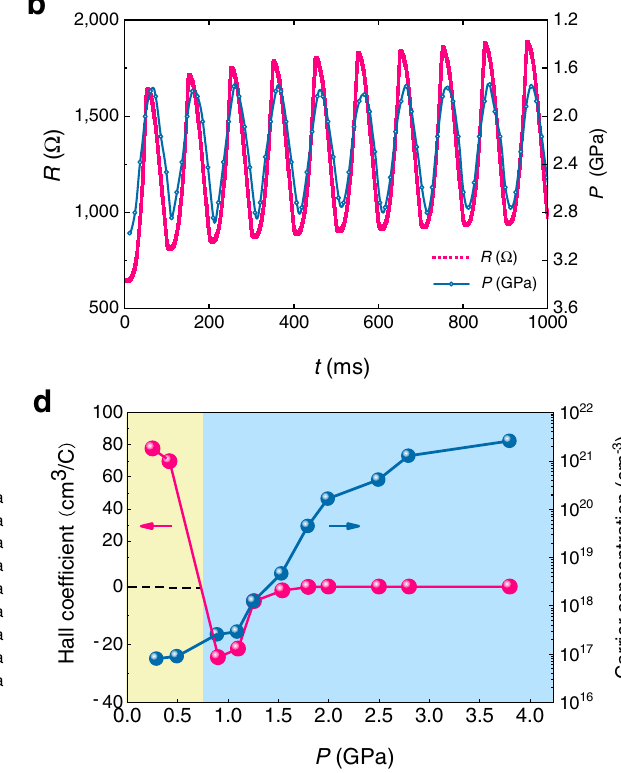
Fig.1|Pressure-inducedresistancedropandHallcoef fi cientmeasurementof β ′ -In 2 Se 3 . a Pressure-dependent resistivity at room temperature. The piezoresistive gauge π p is estimated from the exponential fi t to the data (dashed line) which is a